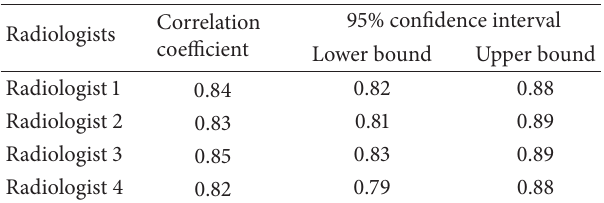
Table 2: Assessment of VUR grading among pediatric